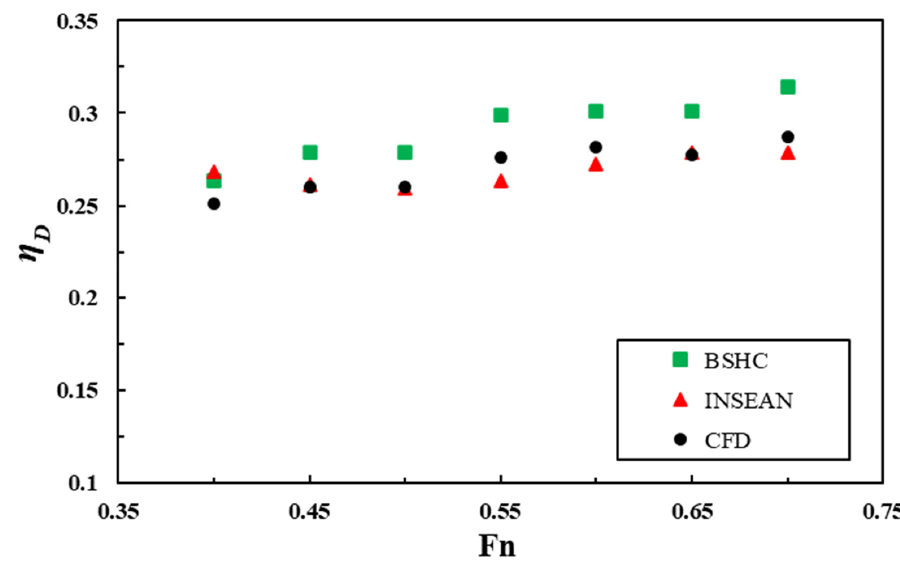
Figure 31. Comparison of the overall efficiency between EFD and CFD.